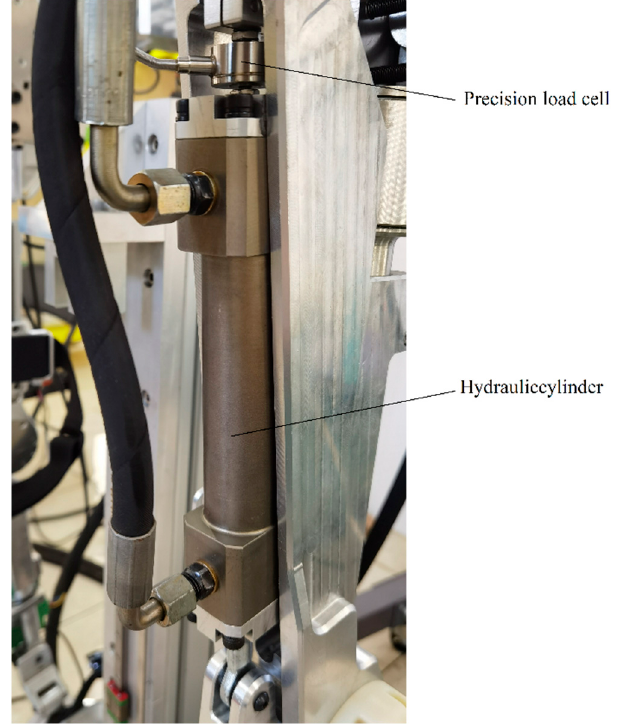
Figure 12. Knee hydraulic cylinder .